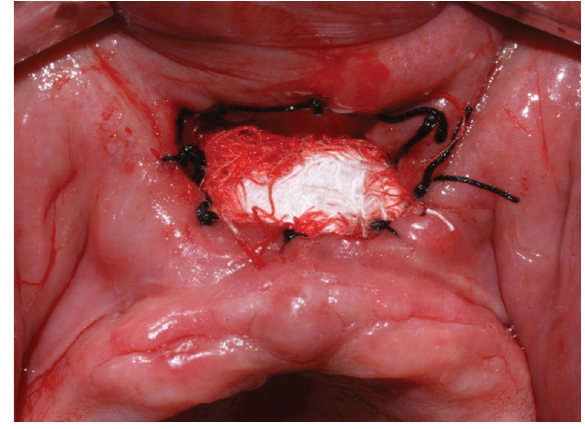
Figure 1. Enucleation. Figure 2. Decompression (using the marsupialization technique).